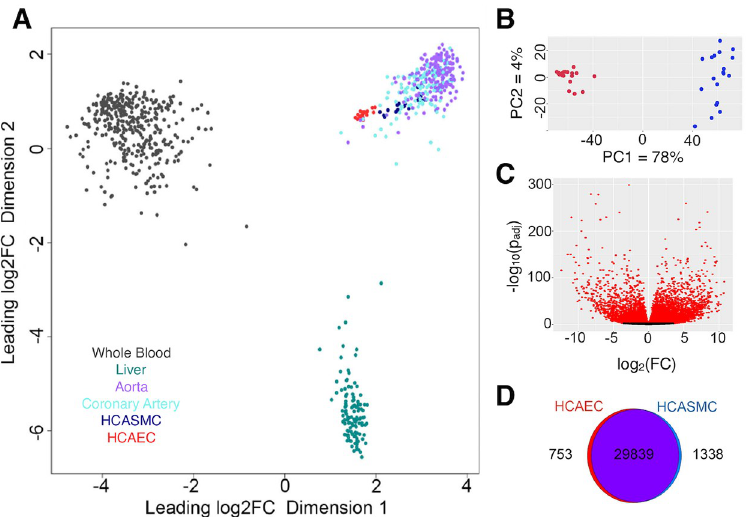
Fig 1. Transcriptional profiling of primary HCASMCs and HCAECs. A) Multi-dimensional scaling plot (500 most differentially expressed genes from RNASeq data from both GTEx–whole blood, liver, aortic and coronary artery samples–and HCASMC and HCAEC samples) highlights that in vitro cultured primary cells cluster with vascular tissues and HCASMCs displays a bigger overlap with the primary tissue. B) Principle component analysis of in vitro cultured coronary artery cells showing 78 percent of the expression variability can be explained by cell type (PC1 –x- axis). Endothelial cells show less transcriptional diversity than the smooth muscle cells (PC2 –y-axis). HCAECs in red, HCASMCs in blue. C) Volcano plot of differentially expressed genes distributed by log2 fold change (x-axis) and adjusted p-value (y-axis). Genes with a positive fold change are overexpressed in HCASMCs relative to HCAECs. Genes in red meet the significance threshold of adjusted p-value � 0.001. D) Venn diagram of genes differentially expressed in HCASMC and HCAEC at adjusted p-value � 0.001 and log2(FoldChange) � -2 or �